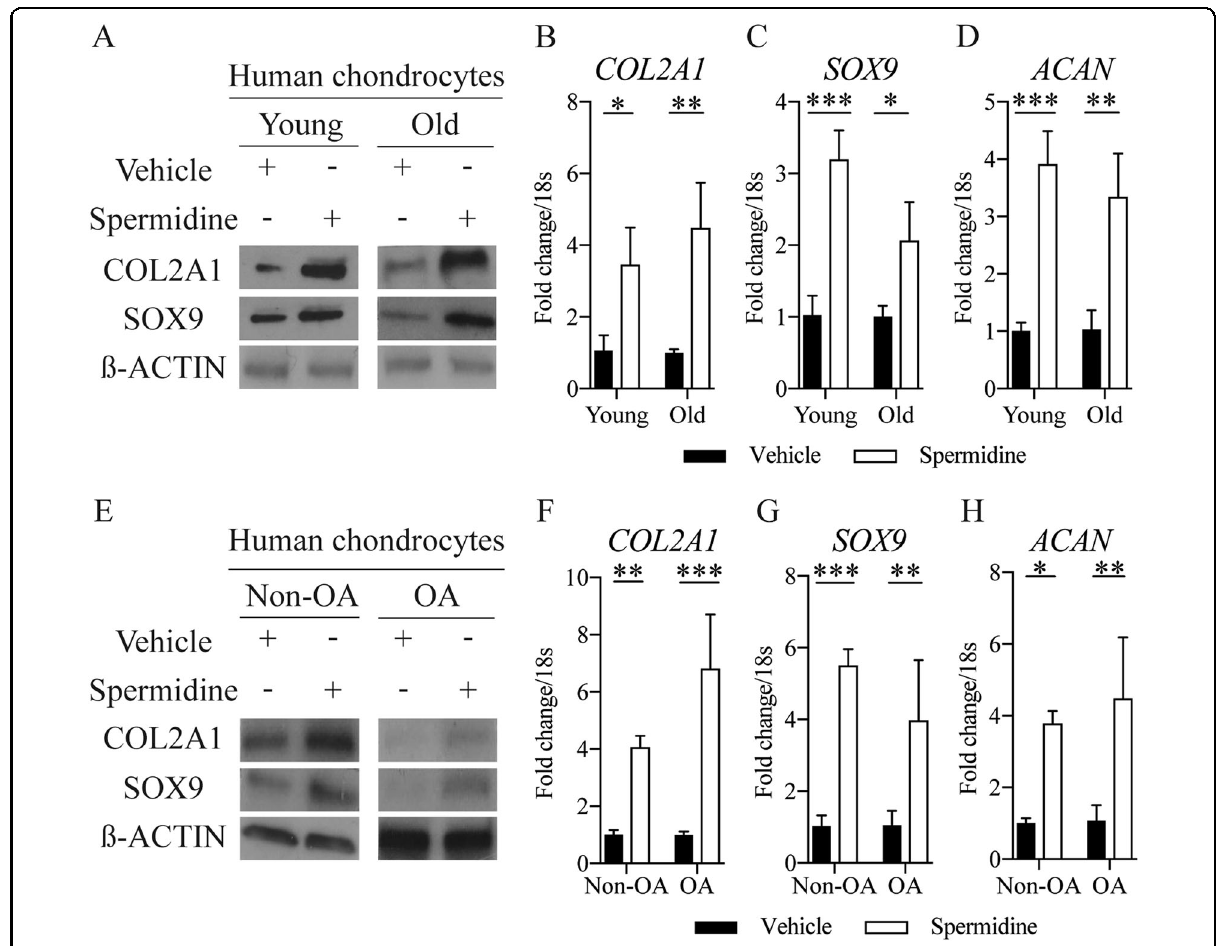
Fig. 3 Spermidine increases the expression of key chondrogenesis markers. a Protein expression and ( b – d ) gene expression (RT-qPCR) of key chondrogenesis markers in isolated chondrocytes from young (21 – 37 years) and old (62 – 68 years) human knee joints treated with DMSO control or spermidine (100 nM) ( n = 3). e Protein expression and ( f – h ) gene expression (RT-qPCR) of key chondrogenesis markers in isolated chondrocytes from non-OA control or OA human knee joints. Cells were either treated with DMSO control or spermidine (100 nM) for 2 h ( n = 3). All RT-qPCR gene expressions were normalised to the endogenous level of 18s. All data are expressed as mean ± S.E.M of n observations. Students unpaired t -test or ANOVA with Tukeys comparison were used for statistical analysis. p < 0.05, p < 0.01 or p < 0.001 represented in all tables and Figures as *, ** or ***, respectively. NS non – signi fi